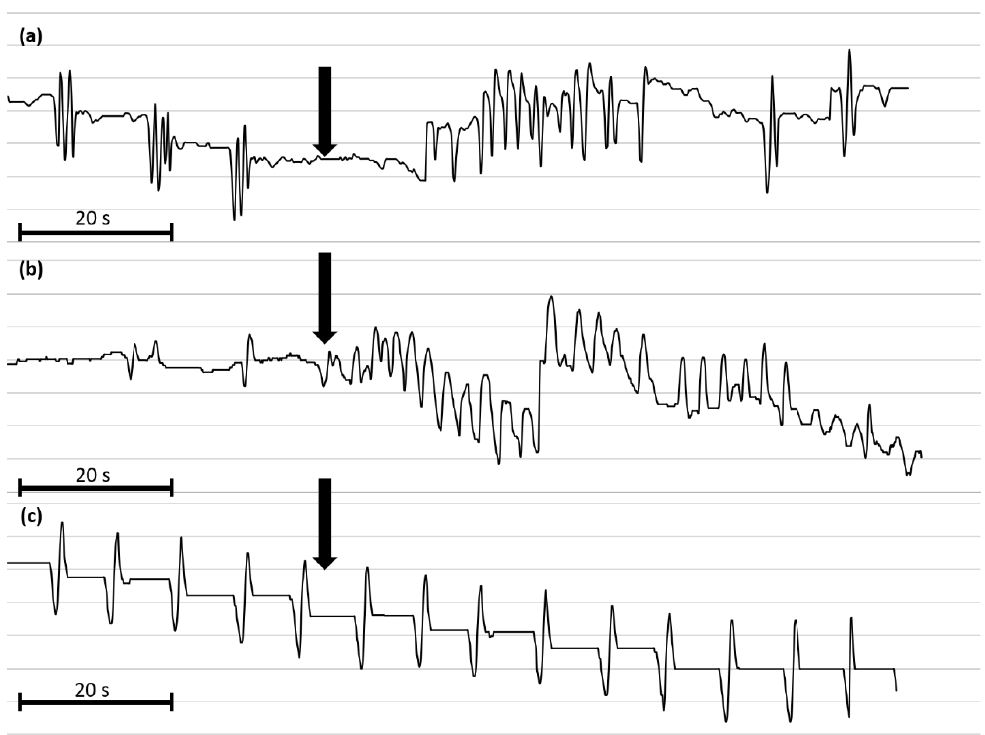
Figure 6. Representative myograms of T. molitor oviduct contractile activity after the application of Tenmo-MIP 5 at 10 –10 mol/L ( a ), proctolin at 10 −5 mol/L ( b ) and physiological saline ( c ). The arrows show the time of neuropeptide application. The scale bars indicate 20 s of video recording.